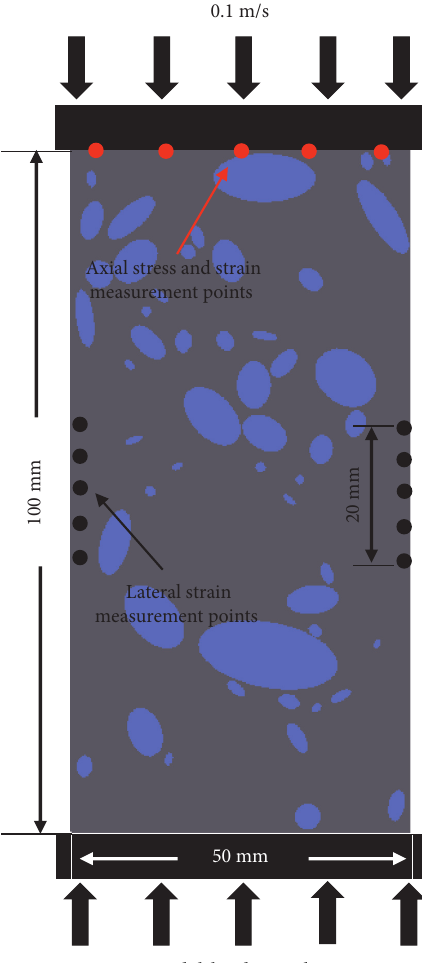
Figure 6: Model loading